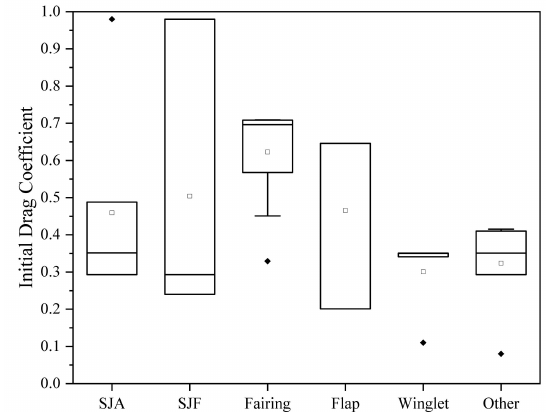
Figure 5. Initial drag coe ffi cient boxplot; (line is median, (cid:3) mean, (cid:7) peaking values, synthetic jet actuators (SJA), steady jet flow